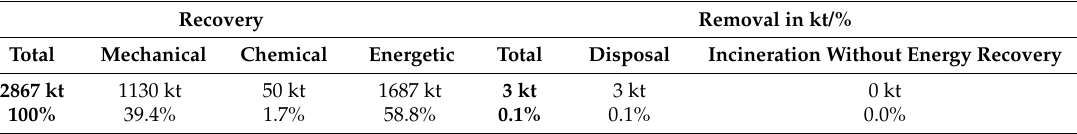
Table 3. Treatment of packaging waste in Germany, 2015